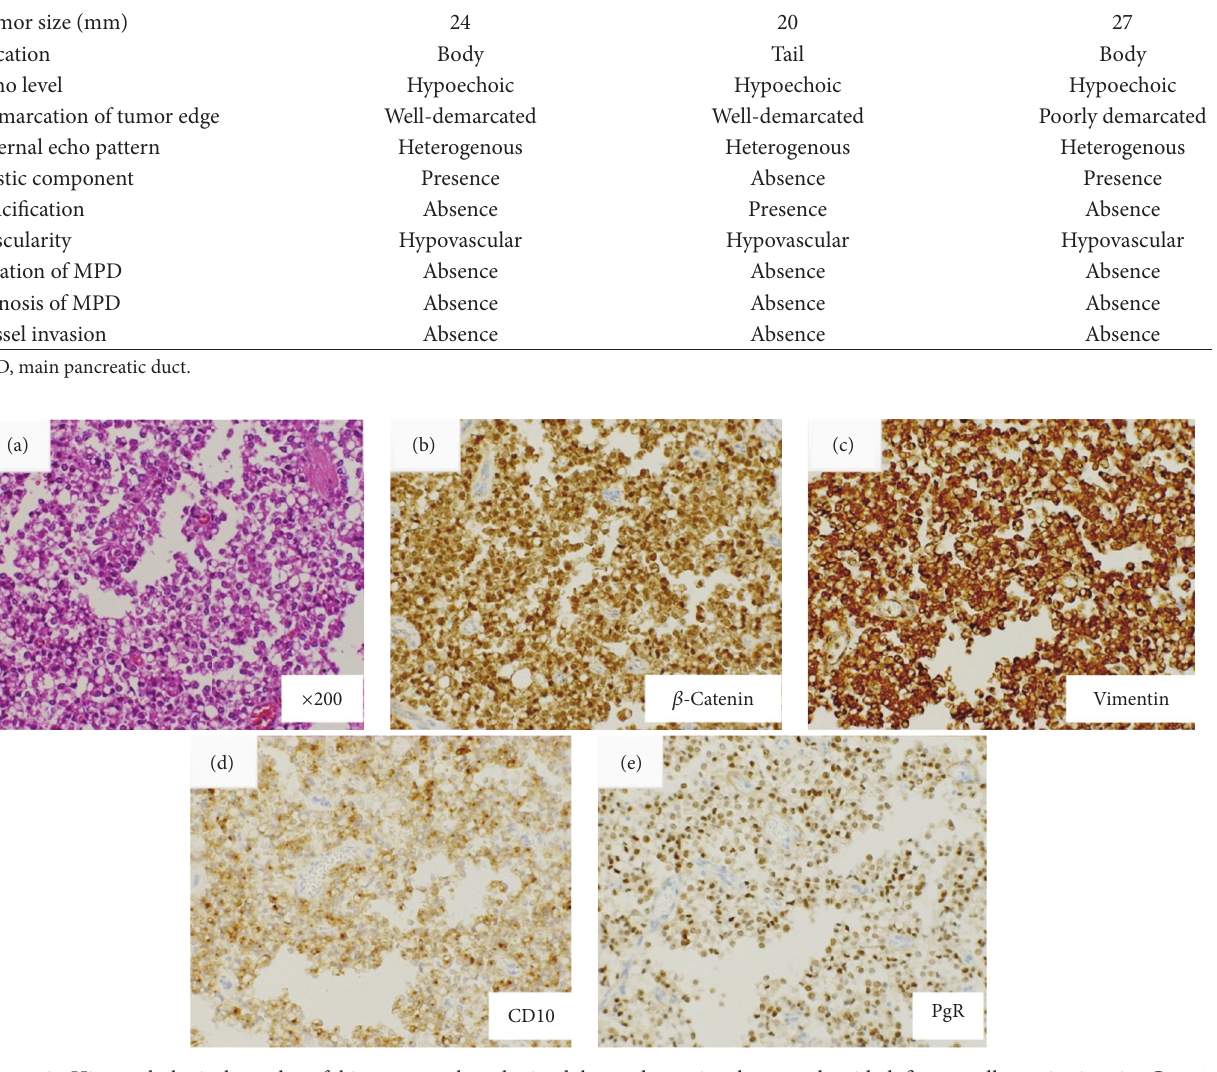
Figure 2: Histopathological results of biopsy samples obtained by endoscopic ultrasound-guided fine needle aspiration in Case 1. Histopathological analyses of the biopsy samples obtained by endoscopic ultrasound-guided fine needle aspiration in Case 1 are shown. (a) Hematoxylin-eosin staining revealed that the tumor cells exhibited acidophilic cytoplasm with small, round nuclei and formed pseudopapillary structures. Immunohistochemical analysis demonstrated that the tumor cells were positive for (b) 𝛽 -catenin, (c) vimentin, (d) CD10, and (e) progesterone